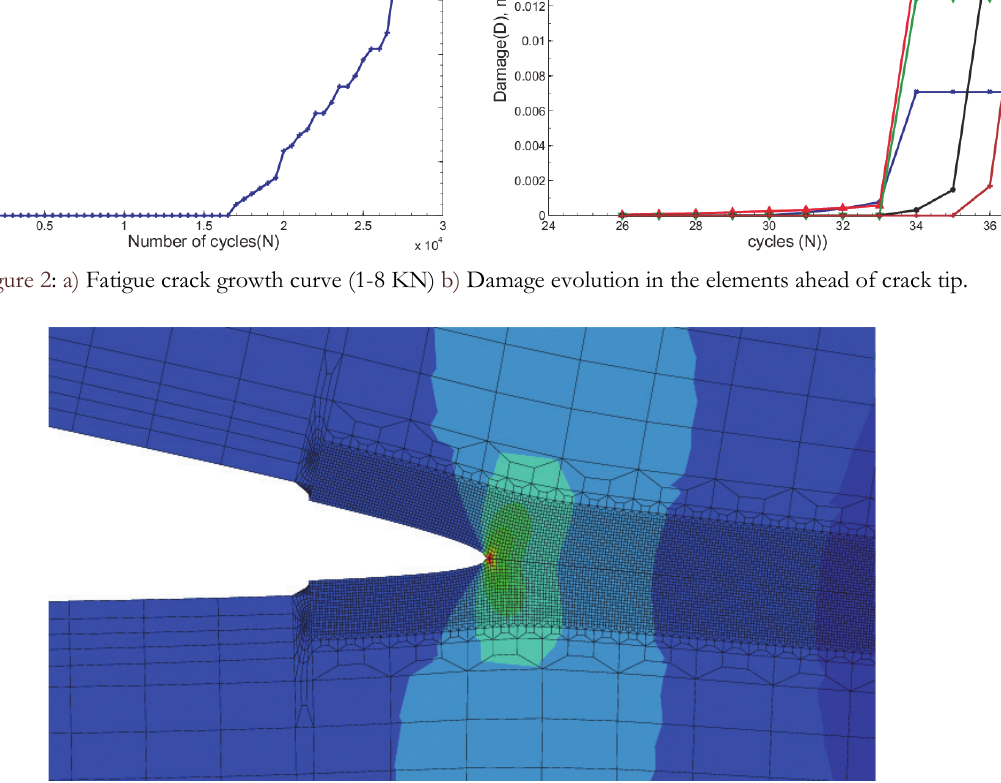
) ahead of the crack tip. yy